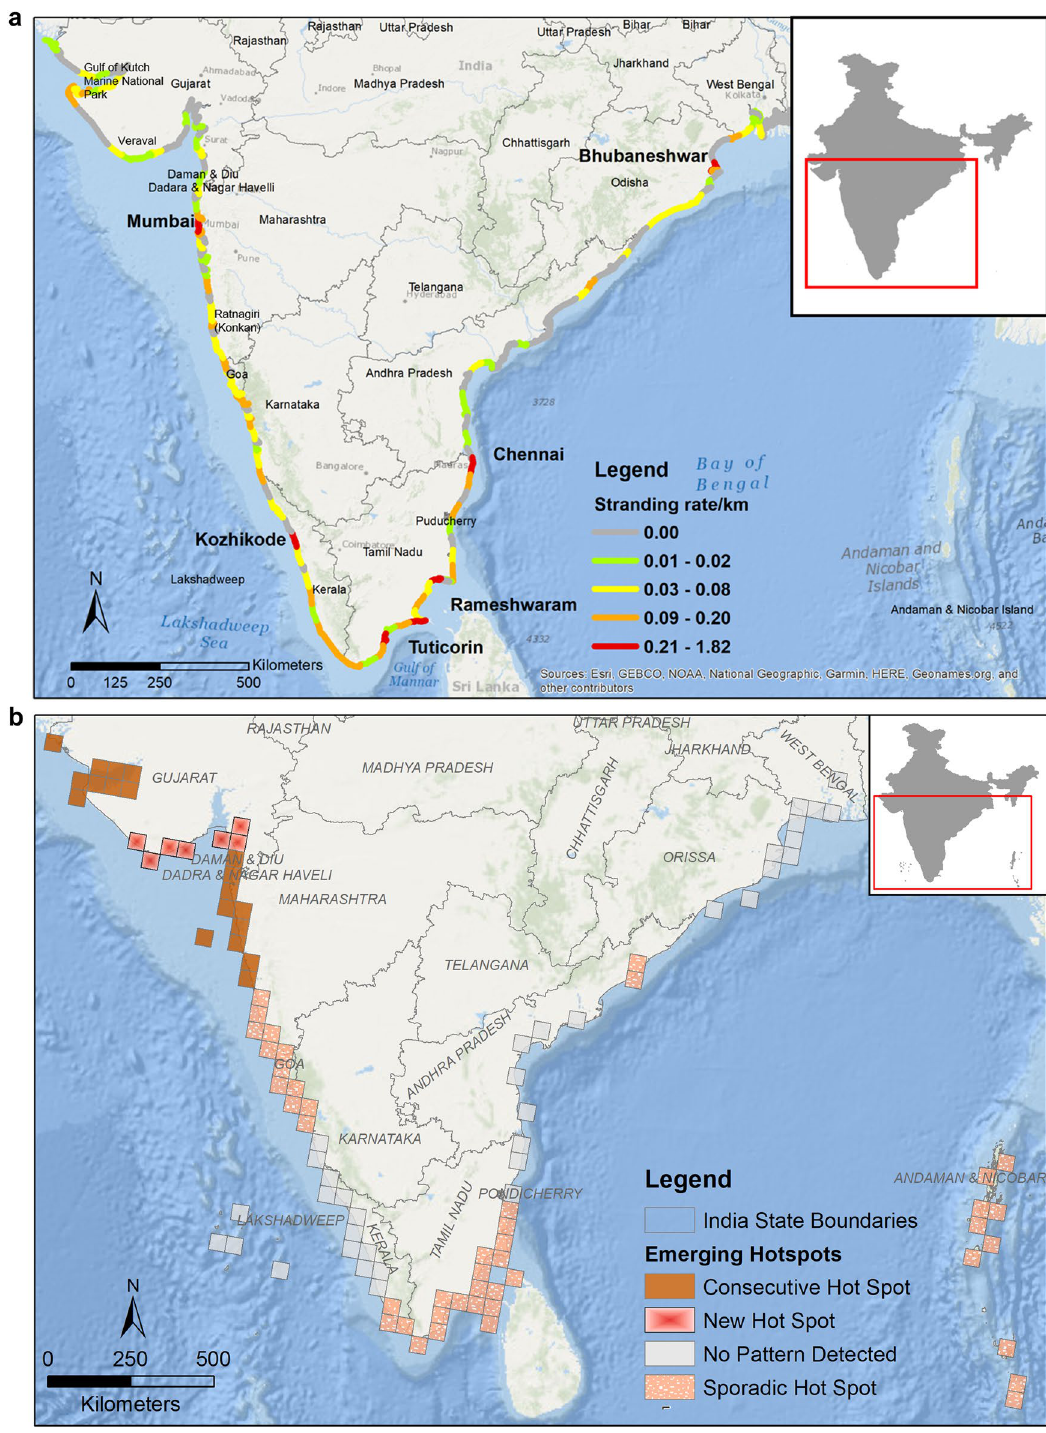
Figure 6. ( a ) Stranding rates (number of strandings/ km) of marine mammals calculated from data compiled between years 1748–2017 along the Indian coastline. High strandings rates (in red) are observed at sections near Mumbai, Kozhikode, Tuticorin, Chennai and Bhubaneshwar. This map was created using ArcGIS 10.5 (https:// deskt op. arcgis. com/ en/ arcmap/ latest/ tools/ analy sis- toolb ox/ near. htm). ( b ) Emerging hotspots obtained from all marine mammal stranding records from data compiled between years 1748–2017 along the Indian coastline. This map was created using ArcGIS Pro 2.4.2 (https:// pro. arcgis. com/ en/ pro- app/2. 8/ tool- refer ence/ space- time- patte rn- mining/ emerg ingho tspots. htm). ( c ) Emerging hotspots obtained from all stranded baleen whale records from data compiled between years 1748–2017 along the Indian coastline. This map was created using ArcGIS Pro 2.4.2 (https:// pro. arcgis. com/ en/ pro- app/2. 8/ tool- refer ence/ space- time- patte rn- mining/ emerg ingho tspots. htm). ( d ) Emerging hotspots obtained from all stranded dolphins and finless porpoise records from data compiled between years 1748–2017 along the Indian coastline. This map was created using ArcGIS